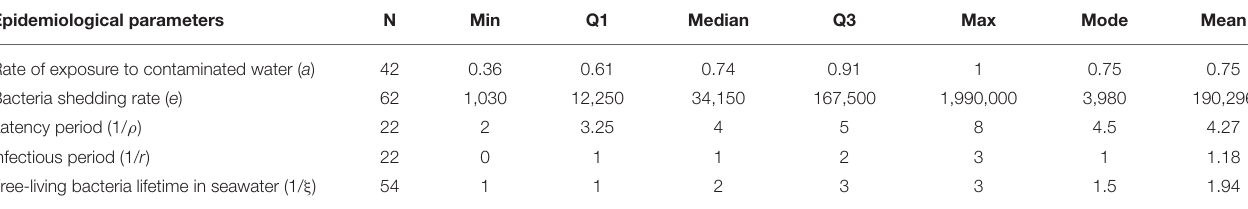
TABLE 3 | Observed distribution characteristics of the epidemiological parameters in the individual laboratory experiments. Epidemiological parameters